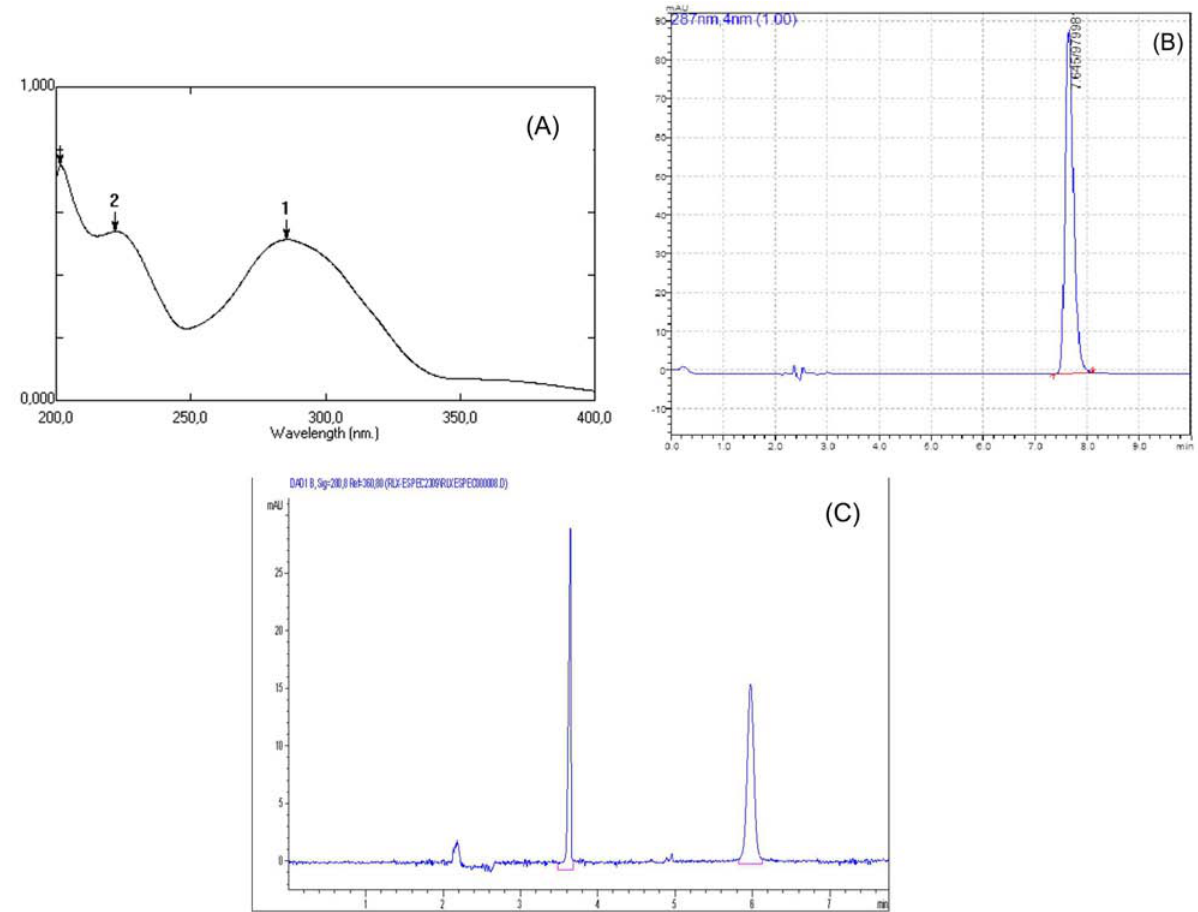
FIGURE 2 - RLX solutions: (A) typical UV spectrum of RLX in 7.5 µg mL -1 , (B) typical chromatogram of RLX in 10.0 µg mL -1 , chromatographic conditions - NST column C18 (250 x 4.6 mm x 5µm), mobile phase of water:acetonitrile:triethylamine (67:33:0,3 v/v), flow rate 1.0 mL min -1 , injection volume 20.0 µl, UV detection 287 nm and analysis temperature 30 °C, (C) typical electropherogram of RLX and DI as internal standard, 80.0 µg mL -1 and 200.0 µg mL -1 respectively, electrophoretic conditions – BGE of boric acid 35.0 mmol L -1 + SDS 50.0 mmol L -1 pH 8.8, fused-silica capillary columm (40 cm length x 50 µm i.d.), hydrodynamic injection time of 4s at pressure 45 mBar, separation voltage 25 kV and column temperature 32 °C with detection at 280